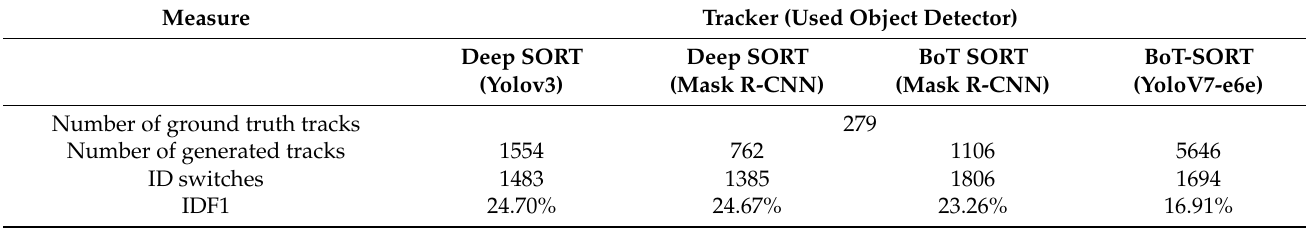
Table 2. Player tracking results on UNIRI-HBD